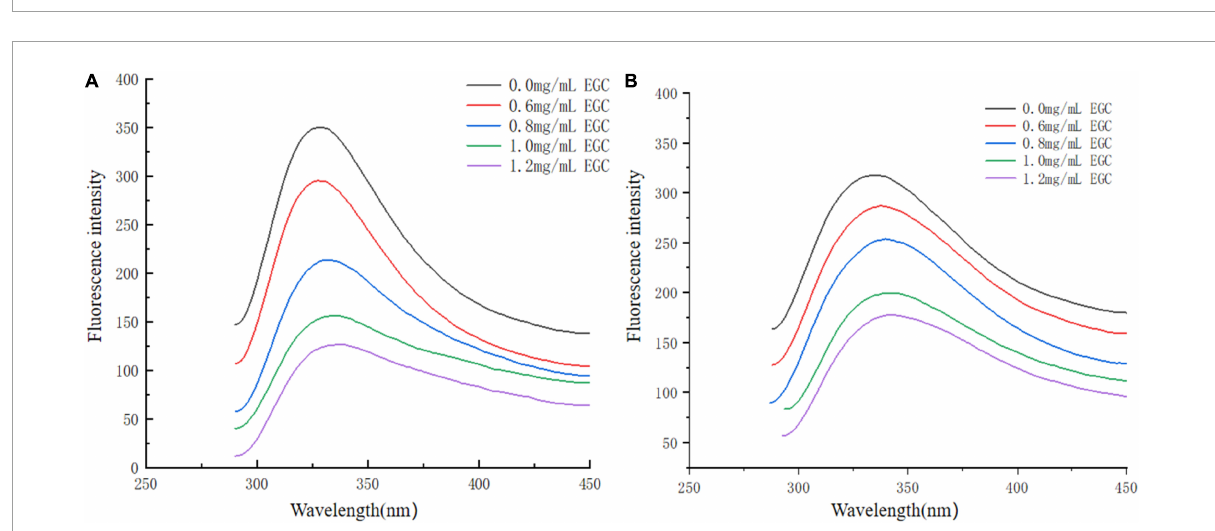
FIGURE5 Fluorescence spectra of α -glucosidase (A) and α -amylase (B) treated with different concentrations of